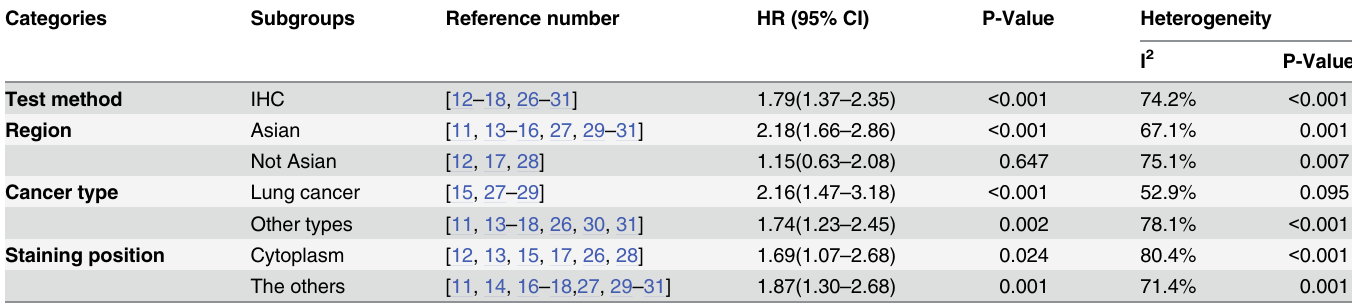
Table 3. Associations between decreased LKB1 expression and OS stratified according to the test method, geographic region, cancer type and staining position.